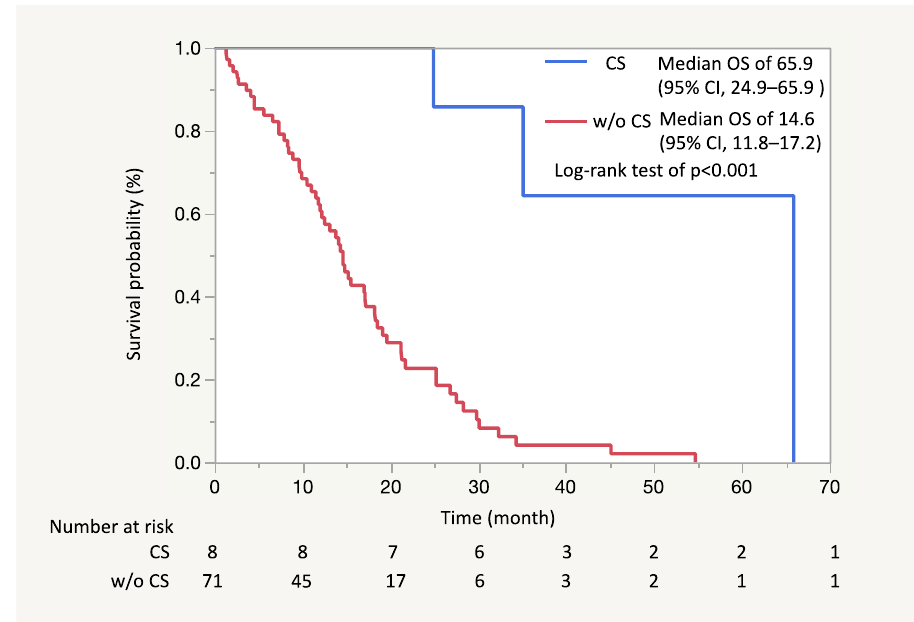
Figure 2. In Kaplan-Meier analysis, the median overall survival (OS) in the patients who underwent conversion surgery was estimated as 65.9 months (95% CI, 24.9–95.9) and was significantly longer than that in all patients without conversion surgery (median OS of 14.6 months; 95% CI, 11.8–17.2) (Log-Rand test of p < 0.001).